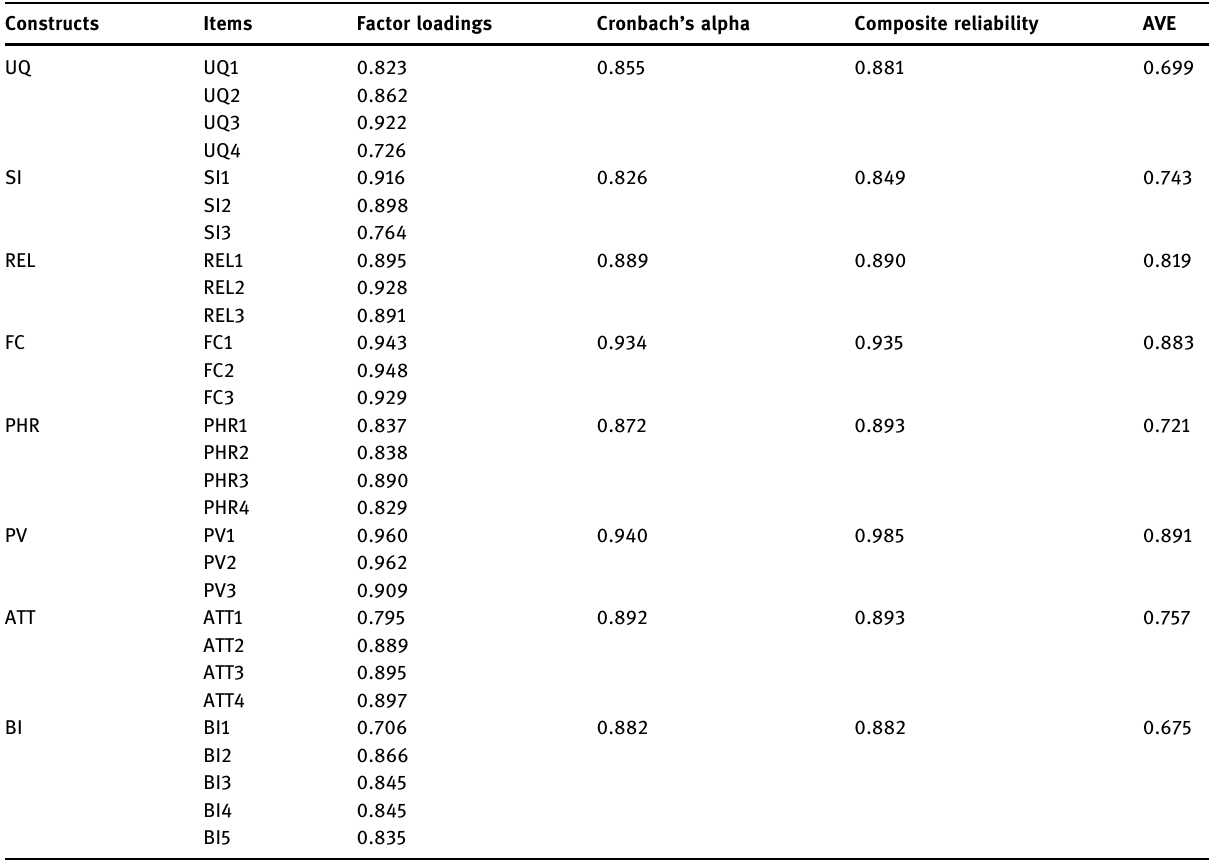
Table 2: Results of the measurement model